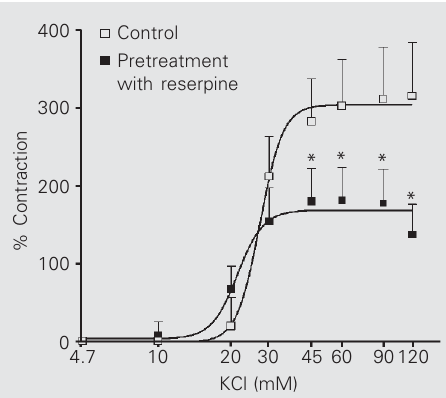
Figure 4. Effect of treatment with reserpine on the contractile responses induced by KCl. Con- centration-effect curves for KCl were constructed for the ano- coccygeus muscle isolated from control rats (N = 35) and rats treated with 5 mg/kg reserpine ( ip , N = 13). Data are reported as means ± SEM. *P<0.05 com- pared to responses by the prepa- rations from control rats and from rats treated with reserpine (unpaired Student t -test).